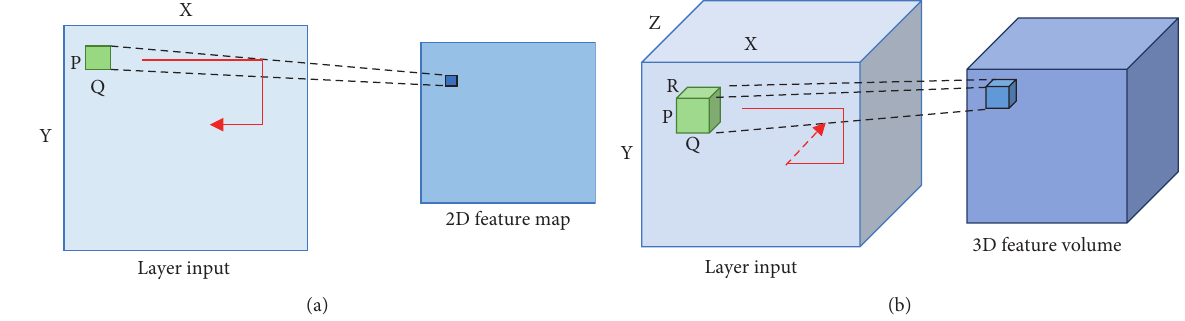
Figure 4: Comparison of (a) 2D convolution and (b) 3D